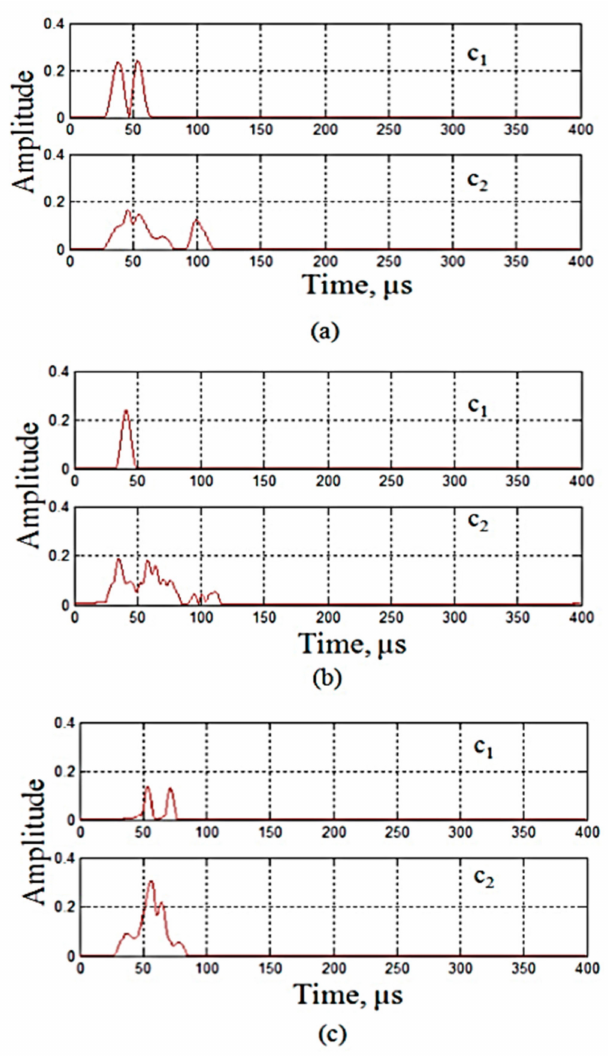
Figure 18. Instantaneous amplitudes of first two intrinsic mode functions (IMFs) using Hilbert transform ( a ) defect-free signal, ( b ) 15 mm defective signal, ( c ) 25 mm defective signal